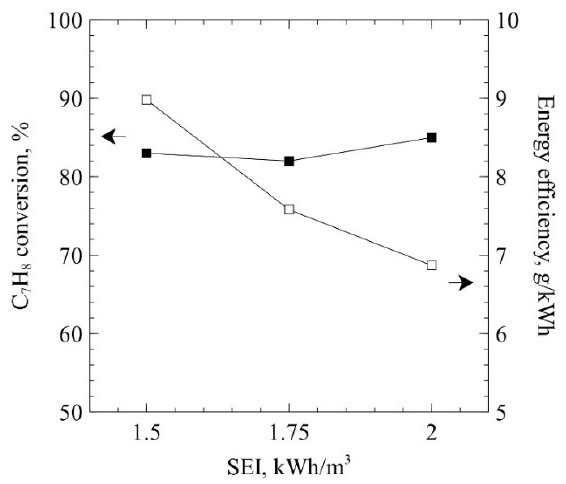
Figure 3. Effect of SEI on toluene conversion and energy efficiency for 4500 ppm initial C 7 H 8 concentration in the plasma–catalytic system with NiO/(CaO ‐ Al 2 O 3 ) catalyst. Series A. The calorific values of the gas after the process were similar to the initial calorific values. They were as high as 5.8 MJ/m 3 and 7.3 MJ/m 3 for series A and B, respectively, in the system with the NiO/(CaO ‐ Al 2 O 3 ) catalyst (Figure 4).